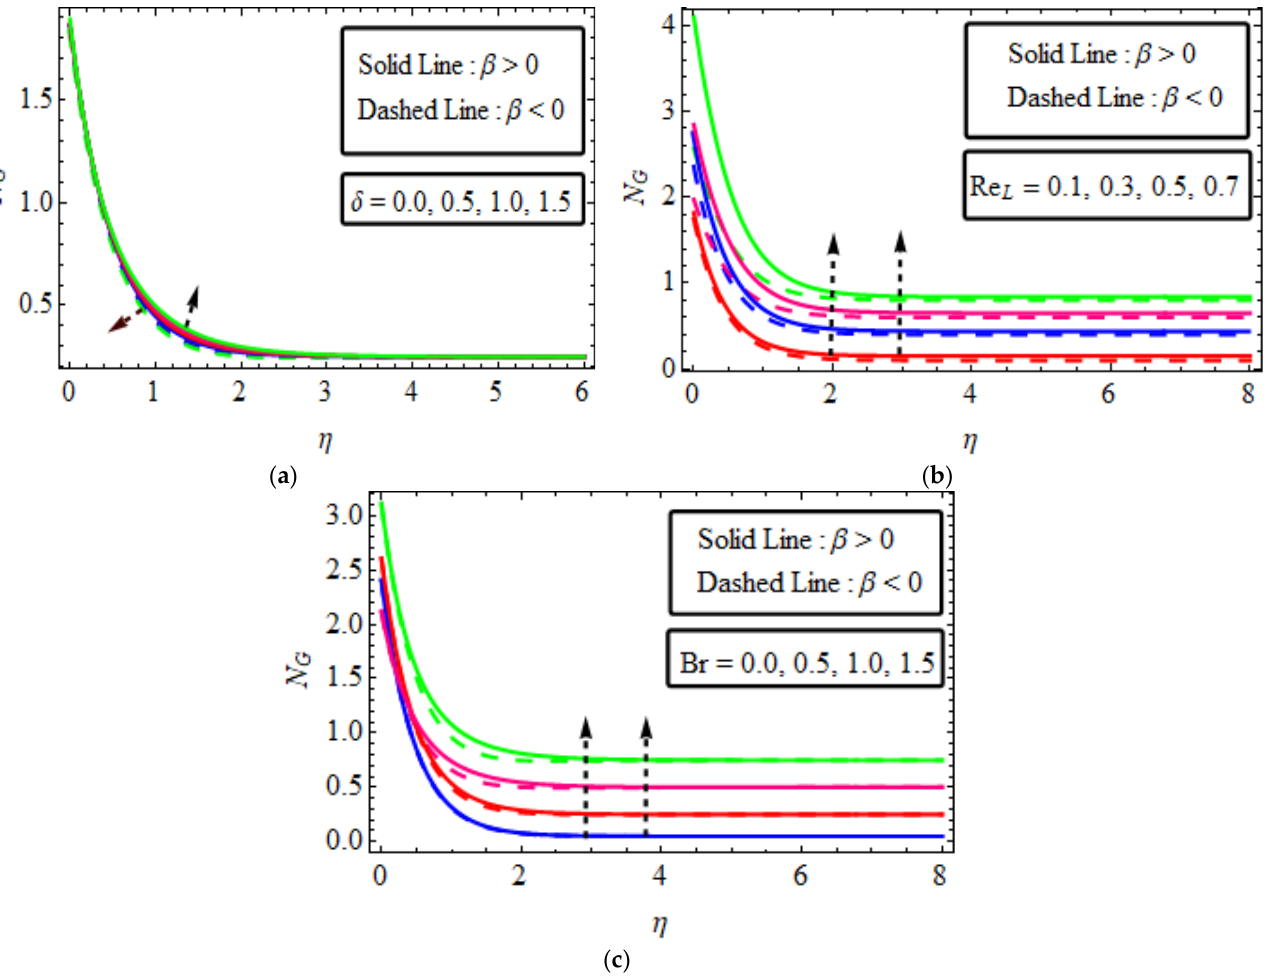
( c ) Br . ( c ) Br . Figure 7. ( a – c ) The impact of N L L